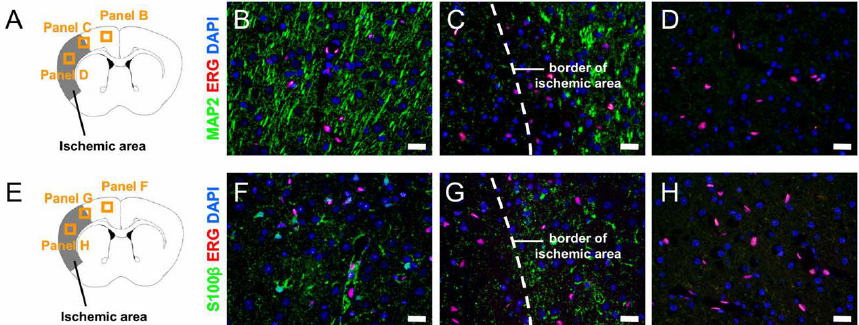
Figure 2. Histopathological findings of mouse brains in stage II. Although immunohistochemistry at post-stroke day 1 showed that reperfusion after ischemia with a duration of 90 min induced cell death of neurons (MAP2 + cells) ( A – D ) and glia (S100 β + astrocytes) ( E – H ) within ischemic areas, some endothelial cells (ERG + cells) ( A – H ) survived (MAP2 ( B – D : green), ERG ( B – D : red), DAPI ( B – D : blue); S100 β ( F – H : green), ERG ( F – H : red), DAPI ( F – H : blue)). Scale bars = 20 µ m ( B – D , F – H ). ERG—ETS-related gene; MAP2—microtubule-associated protein